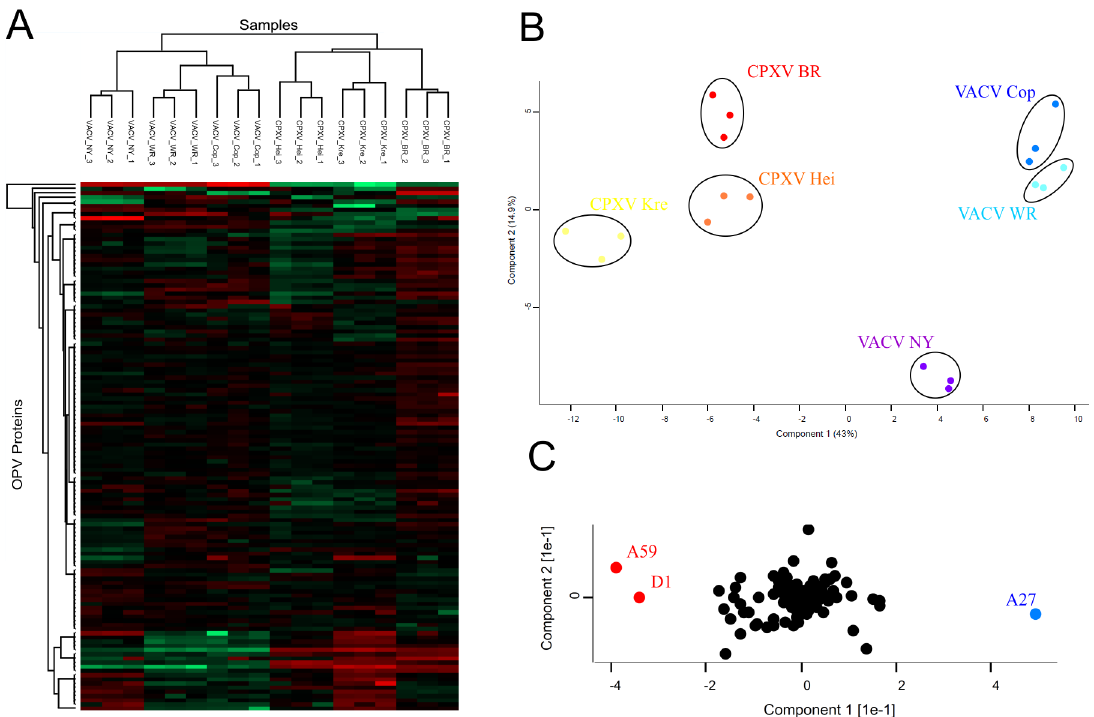
Fig 2. Hierarchical clustering and PCA of viral protein copy numbers. The protein copy numbers of all OPV proteins without missing values were used for hierarchical clustering (A) and principal component analysis (PCA) (B) of the mature virion samples. The biological replicates of each strain cluster together in both analysis and the OPV species, CPXV and VACV, can be discriminated by the mature virion proteome composition. Species-specific proteins were identified from the quantitative comparison using ANOVA tests with a permutation based FDR of 0.01 (Table F-G in S1 File). The main proteins for species classification in the PCA, CPXV-GRI A27, A59 and D1 (C), were among these proteins with significant differences in MV abundance.